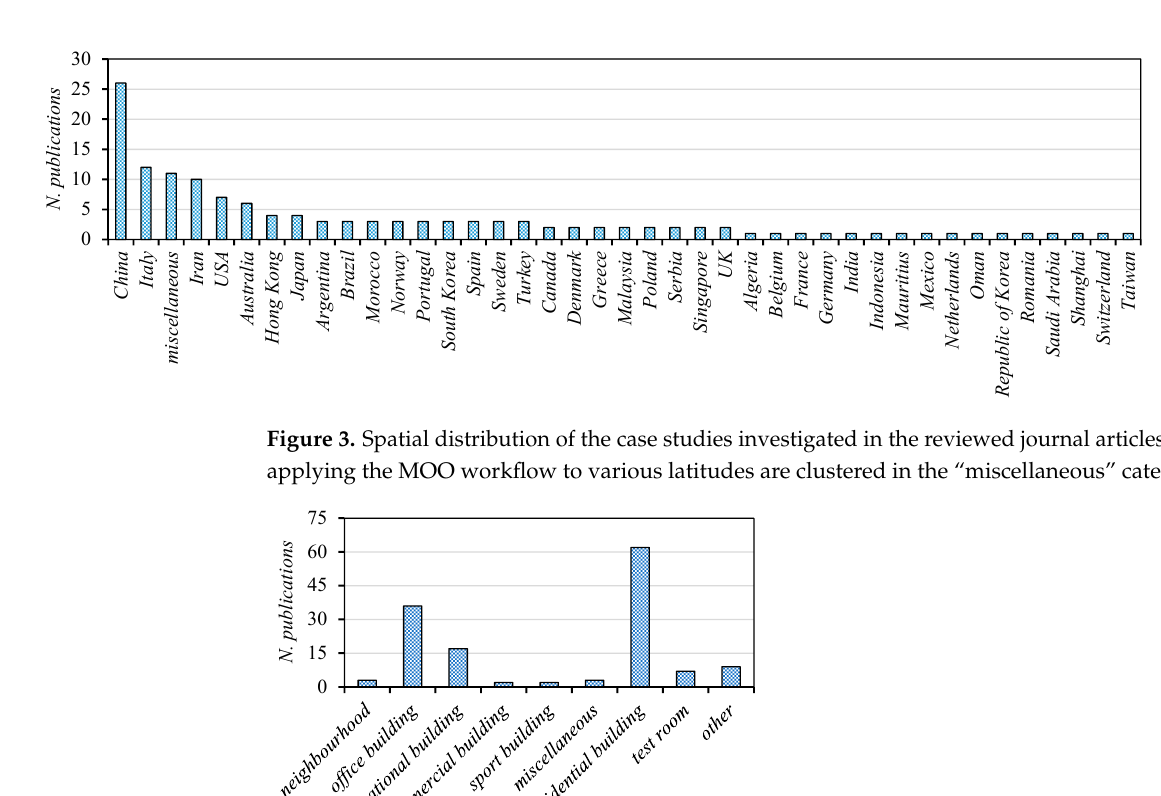
Figure 4. Case study typologies assessed in the reviewed journal articles. The “other” category includes other building typologies such as public buildings and tourist centers.